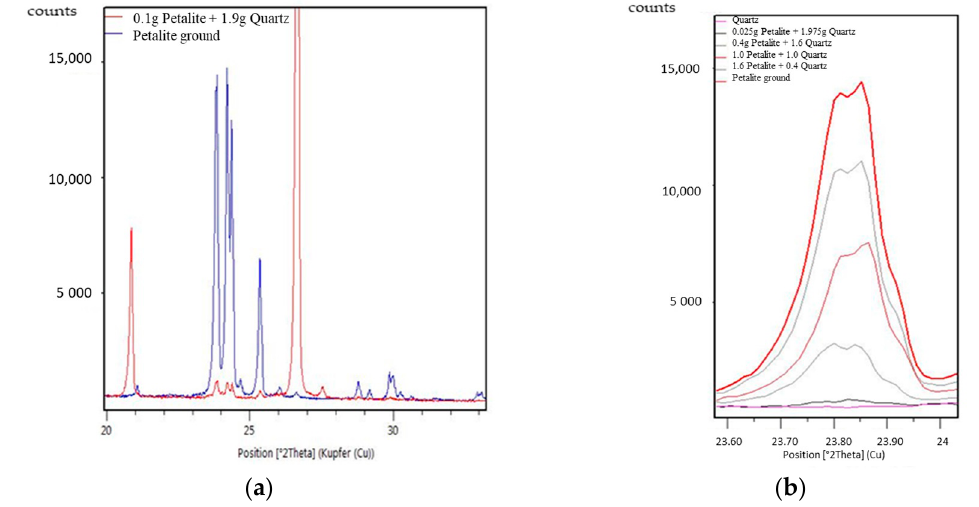
Figure 4. Determination limit of petalite in quartz matrix using main peaks of petalite. ( a ) Part of XRD pattern petalite and mixture of 95% quartz/5% Petalite; ( b ) Main peak of petalite in quartz matrices of different contents